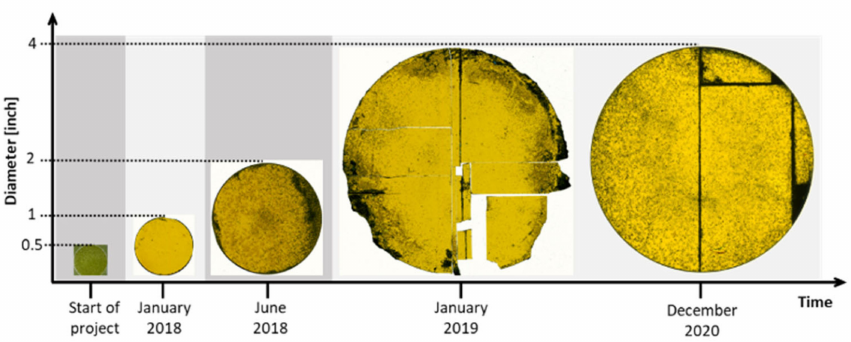
Figure 20. Evolution of diameters for bulk 3C-SiC crystals grown by sublimation growth. The timeline is